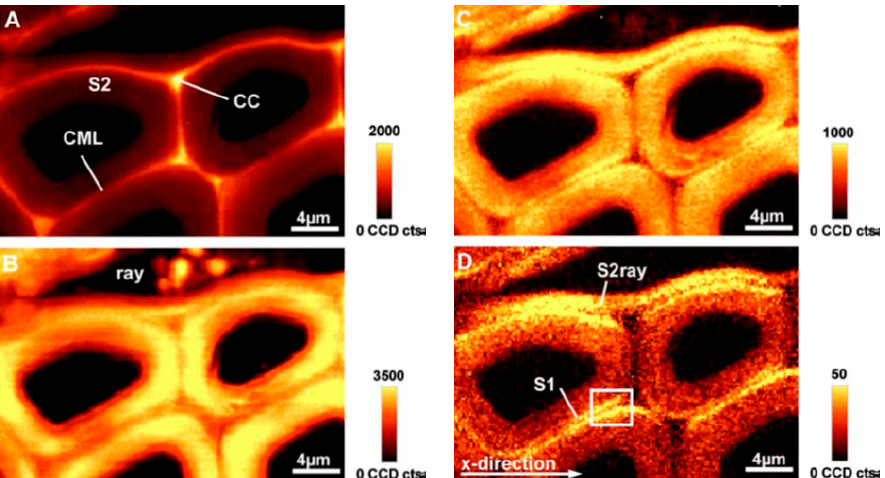
Figure 5. Raman confocal microscopy images of a cross section of poplar latewood. Raman bands: